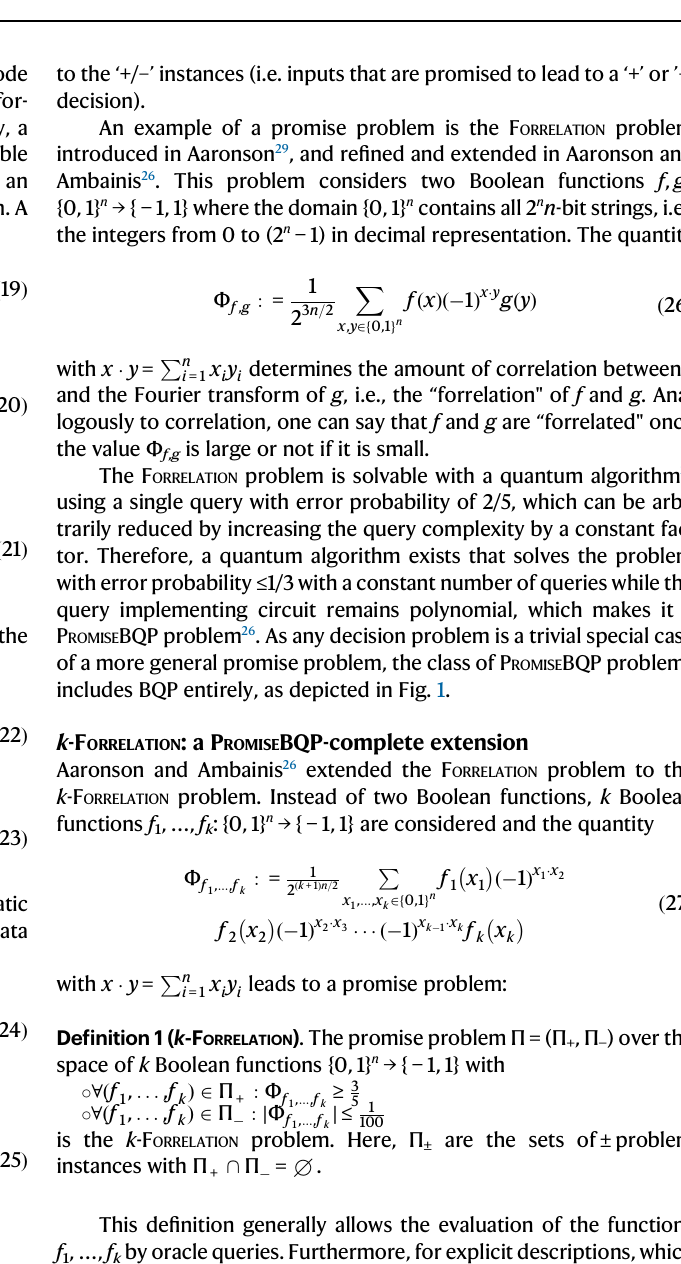
Fig. 2 | Quantum circuits used in the quantum-enhanced classi fi cation algorithms. Diagrams of quantum circuits for a variational quantum classi fi ers (VQCs) and b quantum kernel support vector machines